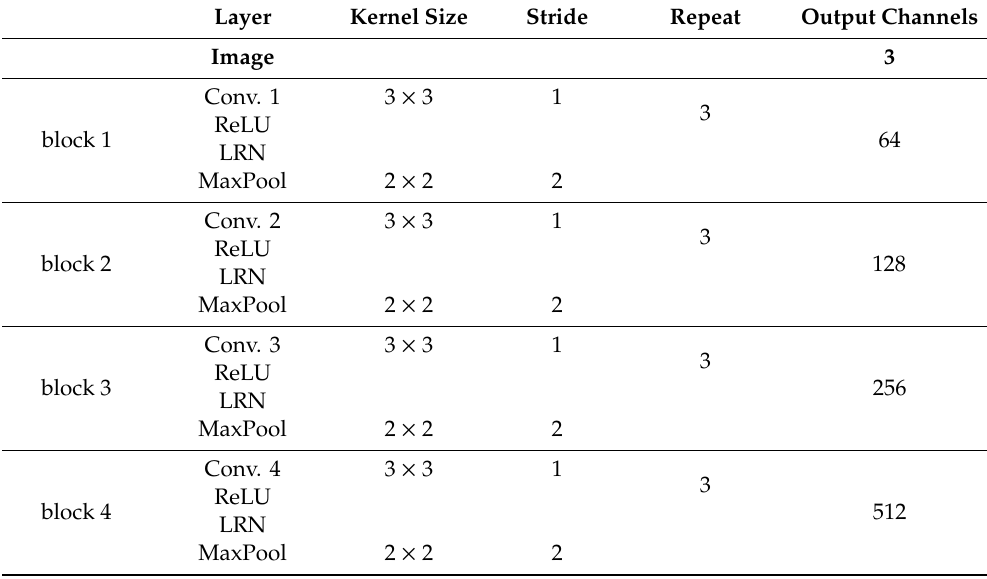
Table 3. The custom DCNN